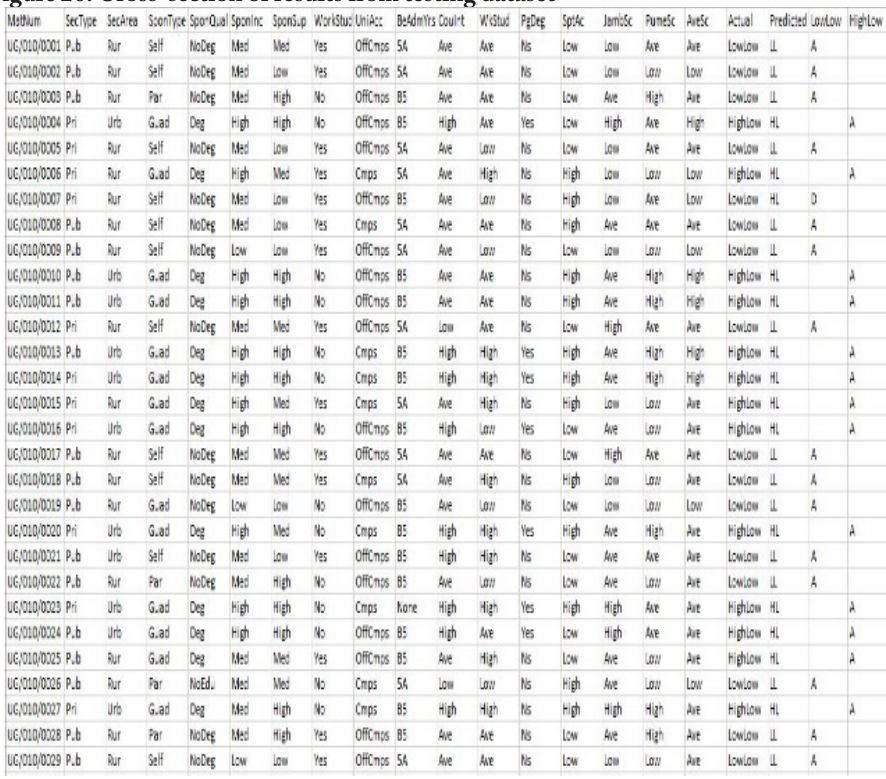
Figure 20: Cross-section of results from testing